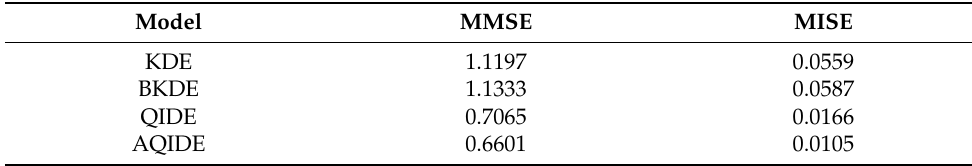
Table 2. Accuracy of univariate